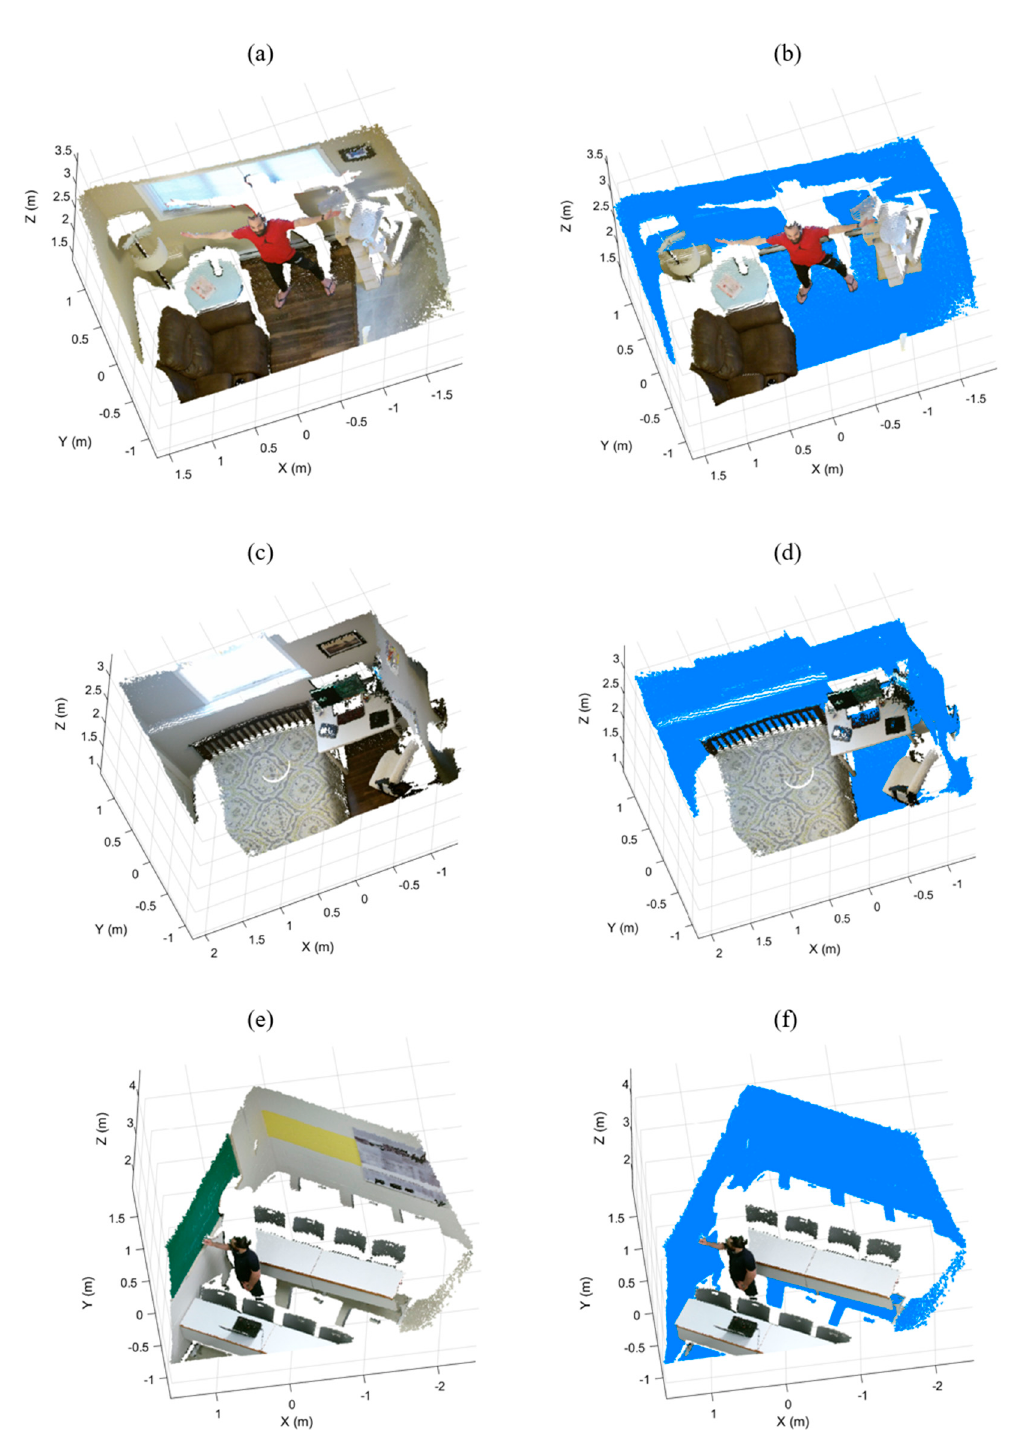
Figure 7. The generated datasets, Room-1 ( a ), Room-2 ( c ), and Room-3 ( e ), and their manually labeled super-surfaces in blue color, ( b ), ( d ), and ( f ) respectively.